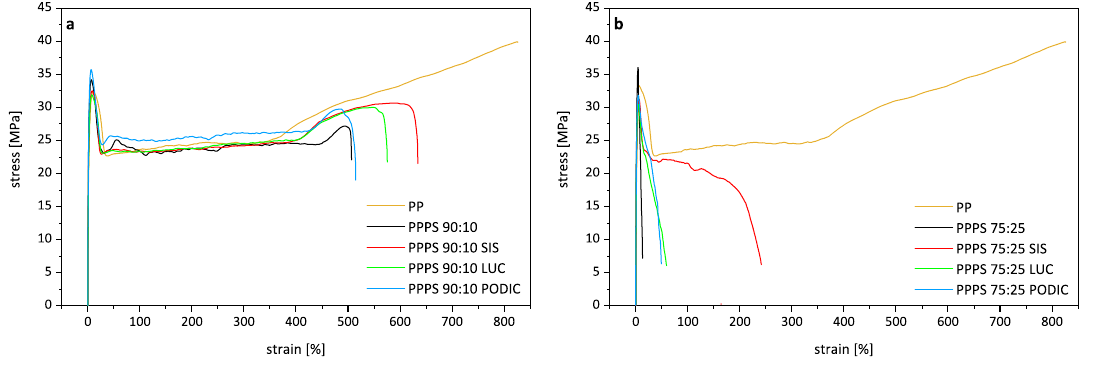
Figure 12. Stress–strain curves for PP–PS 90:10 ( a ) and PP–PS 75:25 ( b ) blends obtained from tensile